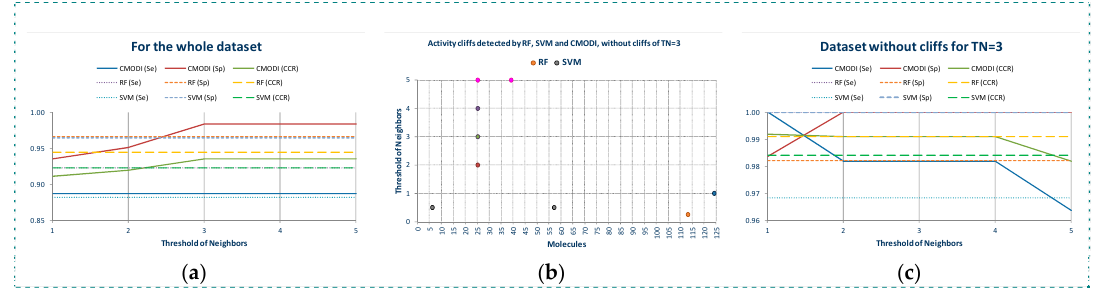
Figure 4. Modelability values and statistic parameter of the classification models built with RF and SVM algorithms for the whole dataset ( a ), outliers detected for the cleaned dataset without the activity cliffs detected for TN = 3 ( b ), and the resulting values of modelability and statistics parameters for the cleaned dataset without activity cliffs ( c ).